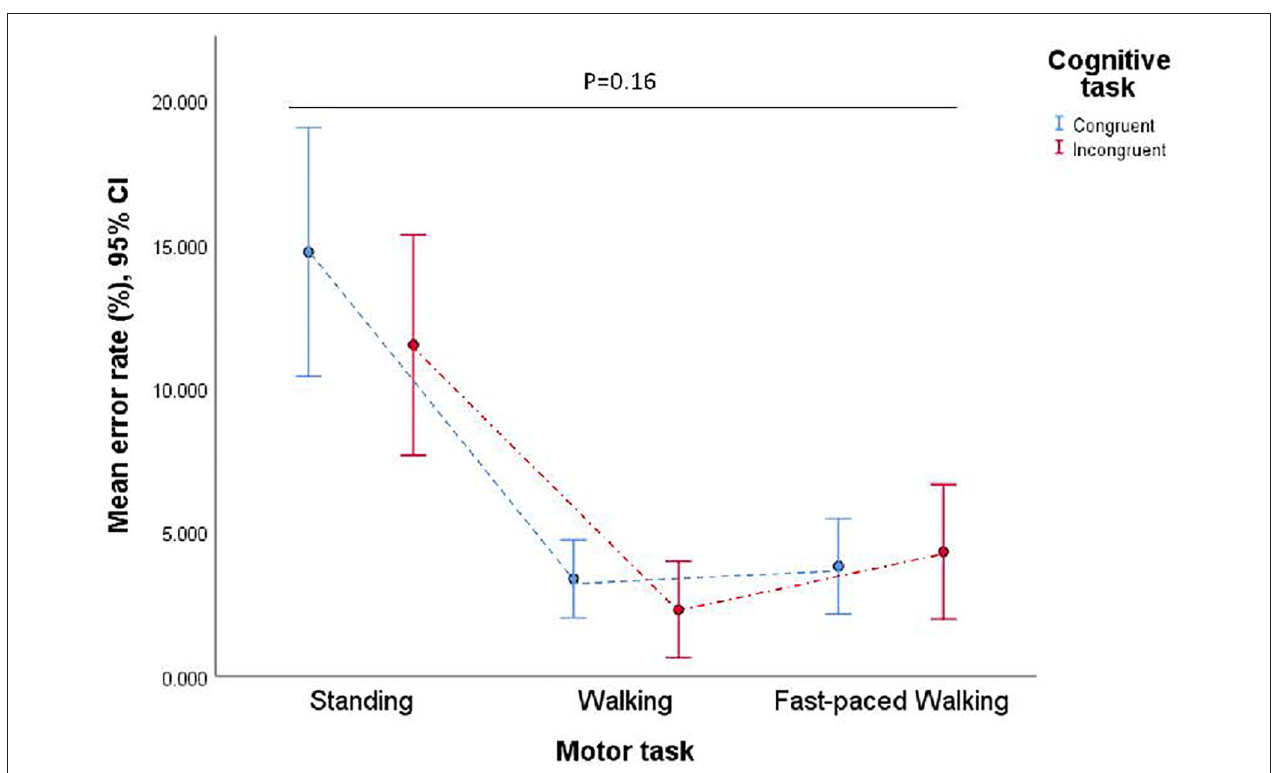
FIGURE 5 | Means error rate for the congruent and the incongruent task in all VR dual-tasking conditions. Figure showing no interaction between motor task and cognitive task on error rate.